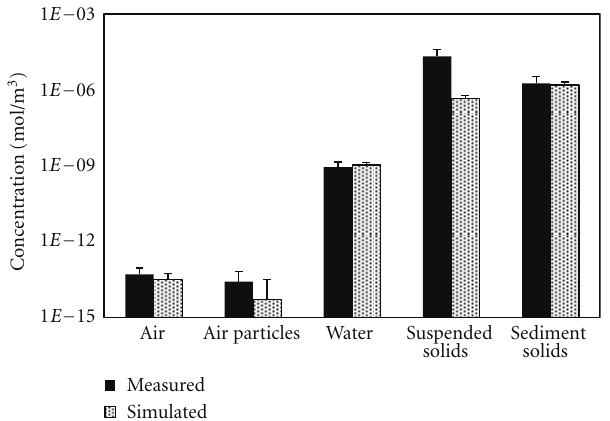
Figure 2: Comparison between the simulated and measured α -HCH concentrations in the air, water, and sediment of Lake Chaohu. The error bars included in this figure represent the standard deviations.